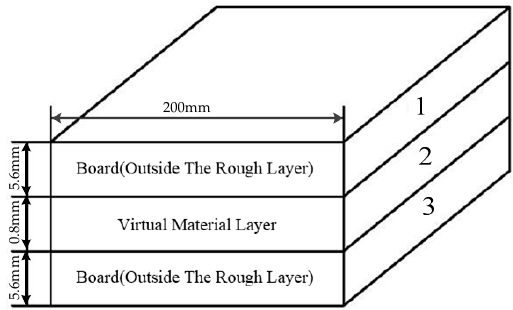
Figure 2. Schematic diagram of the three-dimensional model of VMM.